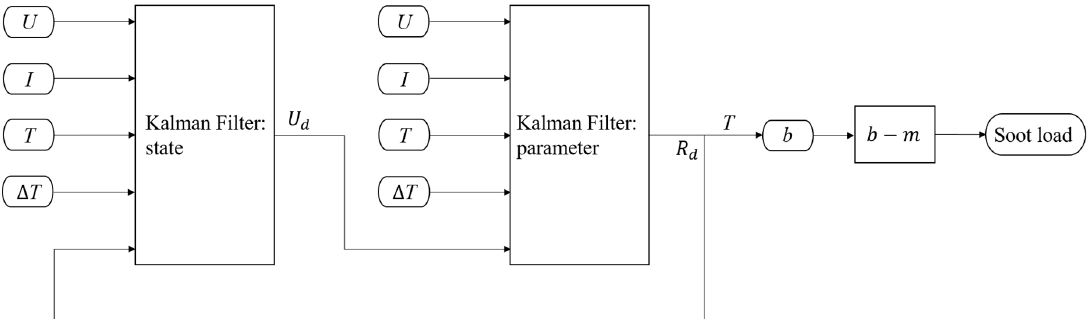
Figure 4. Online estimation process of the soot load.